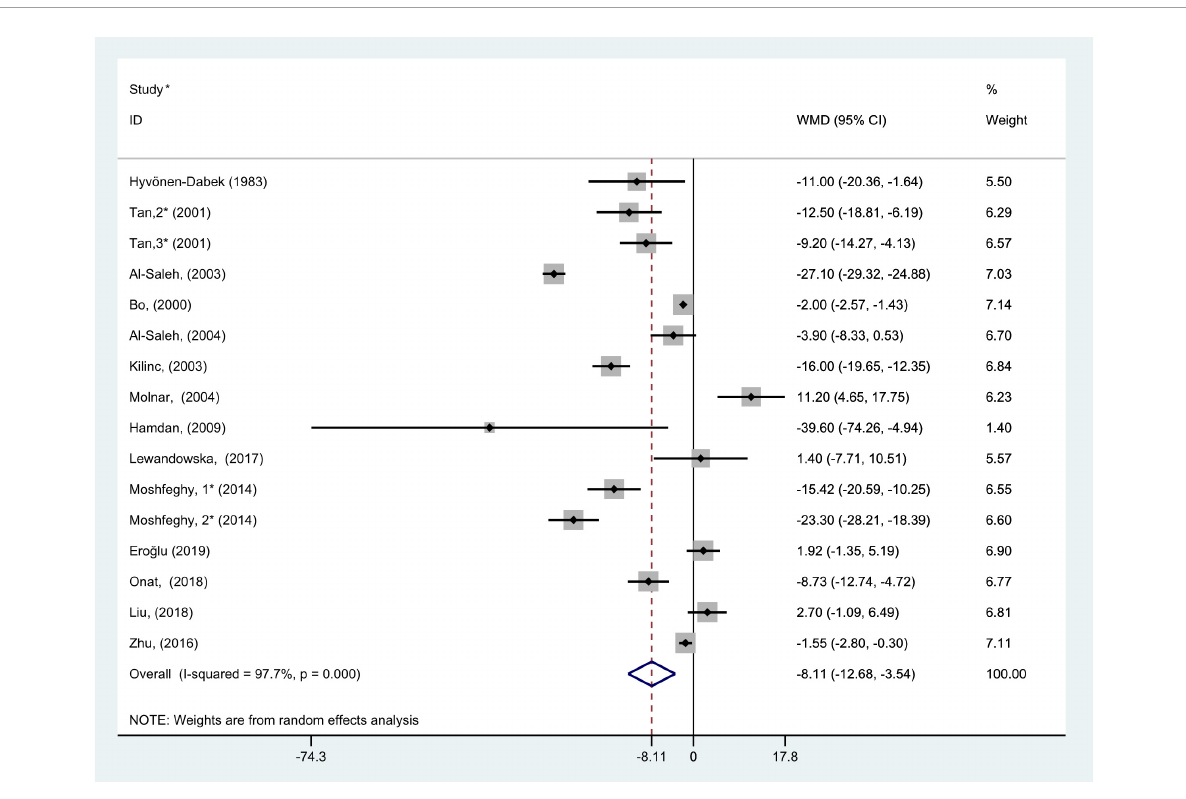
Supplementary Table 1 . A total of 14 relevant studies